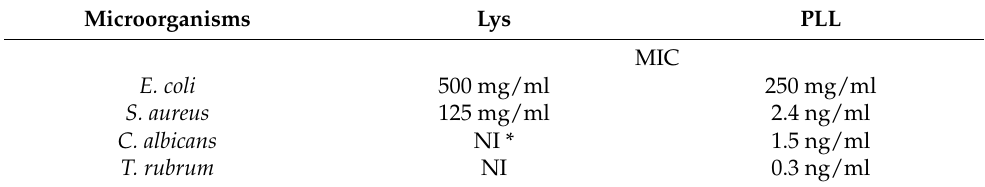
Table 1. Minimal inhibitory concentration of L-lysine (Lys) and poly-L-lysine (PLL) on microorganisms. Microorganisms Lys PLL MIC E. coli 500 mg/ml 250 mg/ml S. aureus 125 mg/ml 2.4 ng/ml C. albicans NI * 1.5 ng/ml